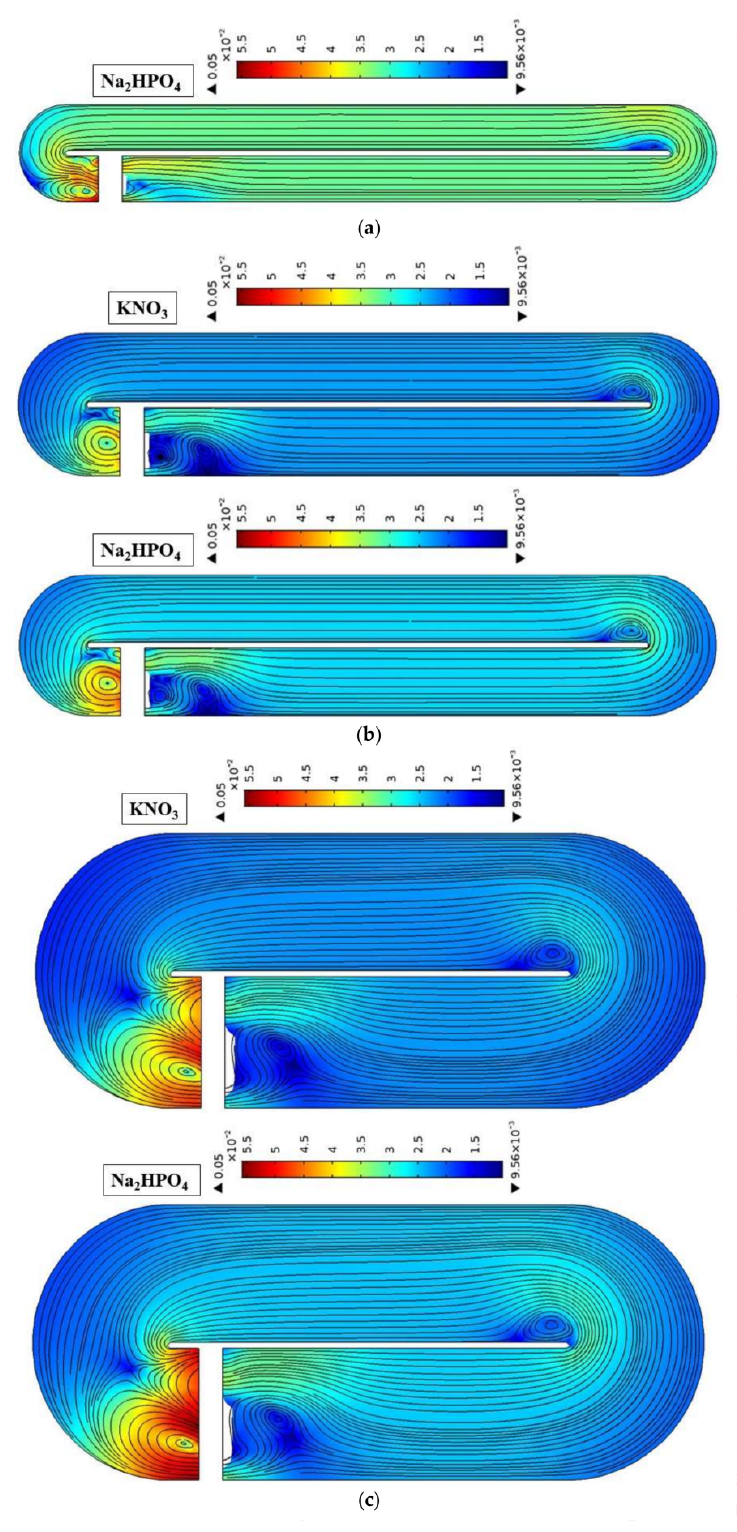
Figure 5. Solid–liquid mass transfer coefficient (surface plots) and water velocity (streamline plots) for different AR s: ( a ) 5; ( b ) 10; and ( c ) 15 at water depth = 0.2 m and paddle wheel speed =